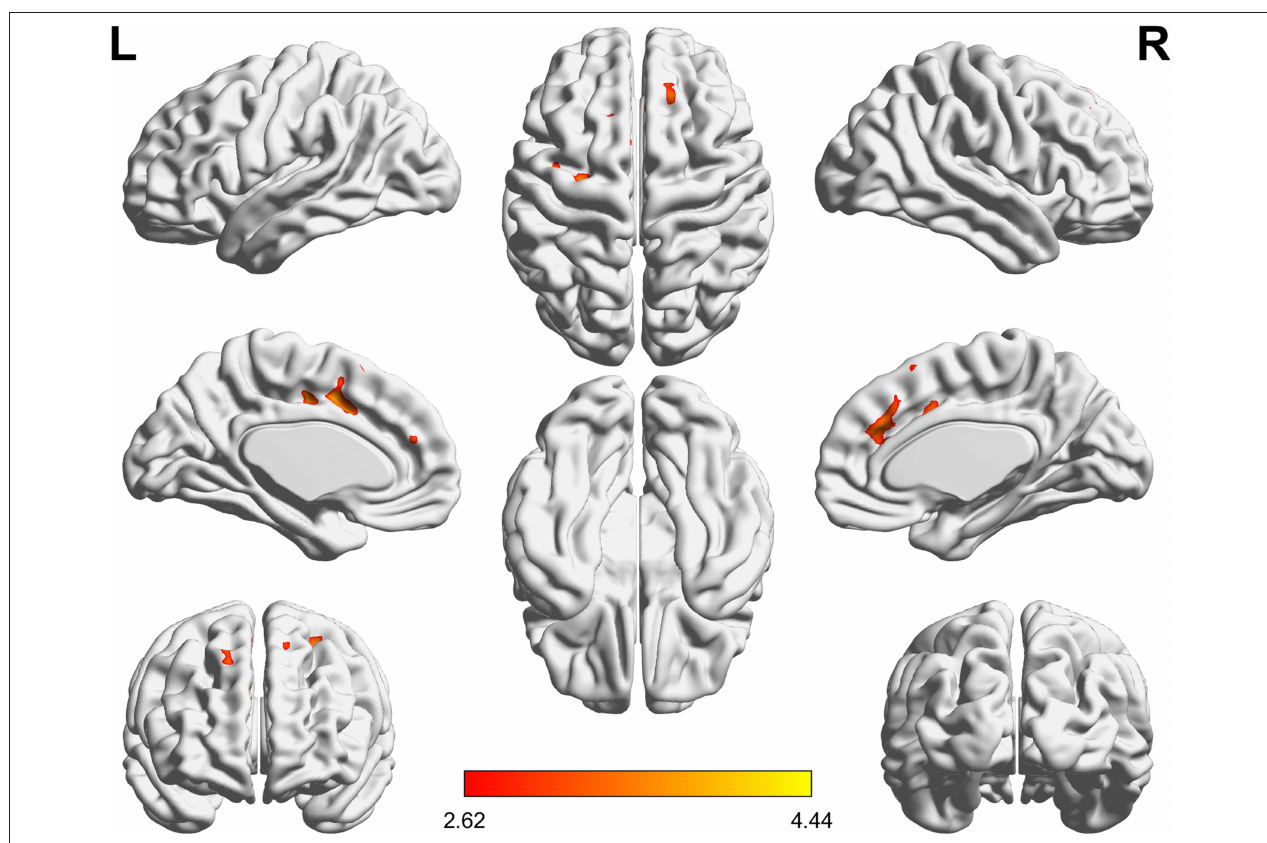
FIGURE 4 | ReHo differences between PI patients and HC (PI-HC). The threshold was P < 0.01 at the voxel level, with Alphasim corrections for multiple comparisons of P < 0.05. The color bar represents the t value. ReHo, regional homogeneity; PI, primary insomnia; HC, healthy controls. decreased inhibition of the caudate nucleus on brain